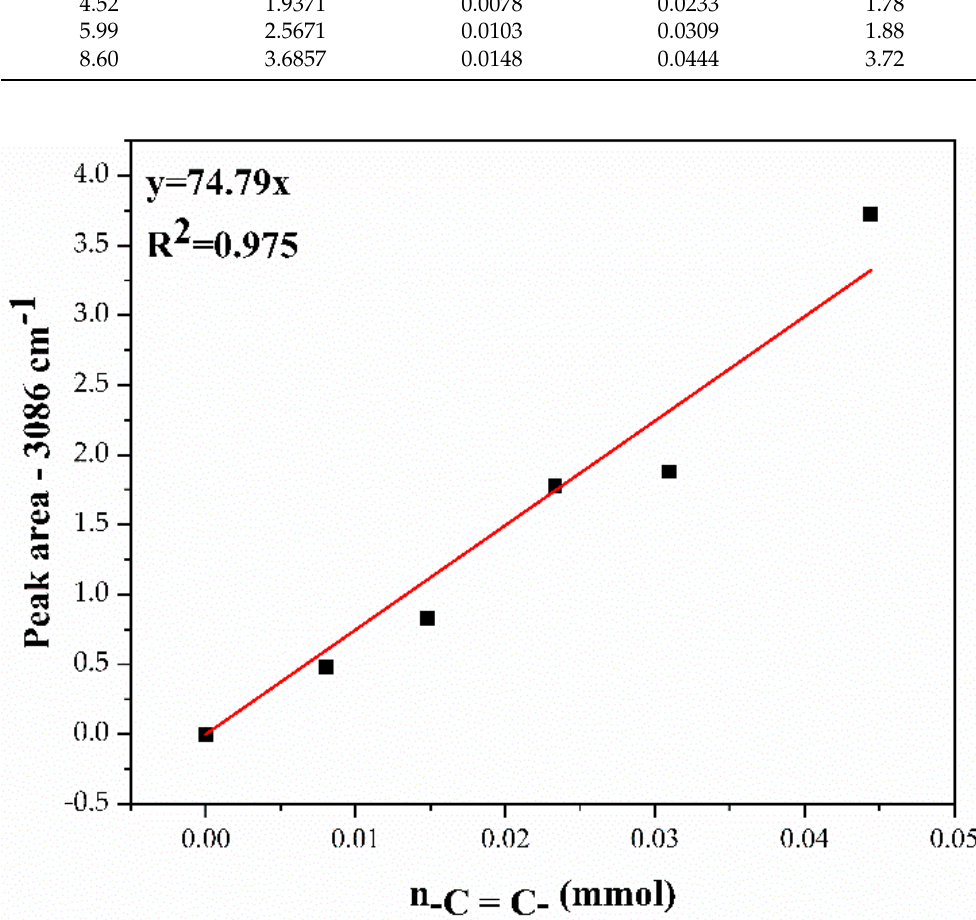
Figure 5. The calibration curve for –C=C– absorbance of TAIC at 3086 cm − 1.